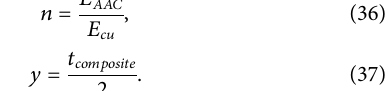
TABLE 5 Results for the comparison between experimental, fi nite elements, and computational analysis at the de fl ection of all of the different models. Model De fl